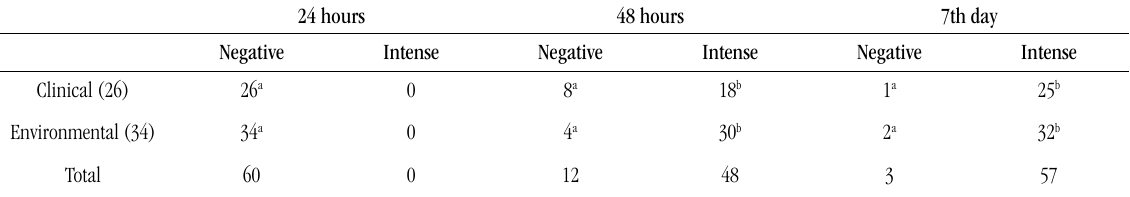
tABLE 10 – Protease production activity in clinical and environmental Cryptococcus neoformans samples isolated in Sergipe, Brazil